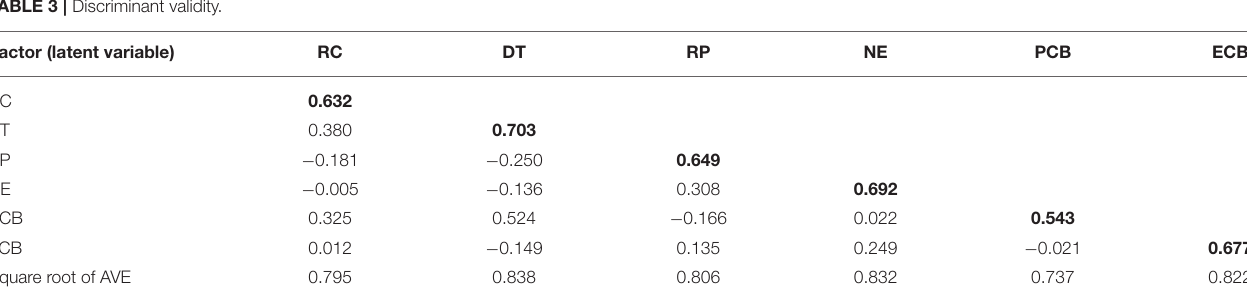
TABLE 3 | Discriminant